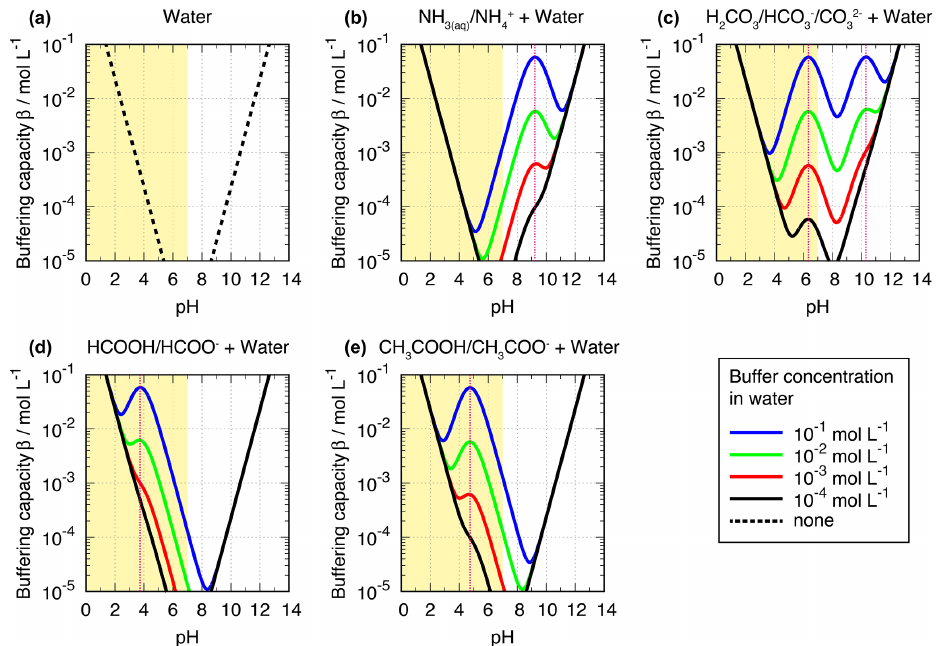
Figure 4. Buffering capacity β of (a) water, (b) ammonia or ammonium, and (c) carbonate, bicarbonate, or carbonic acid (top), as well as (d) formic and (e) acetic acid (bottom), as a function of pH. The atmospherically relevant range of cloud and aerosol pH is marked in yellow, and the pK a values of the corresponding buffers are marked with dotted pink